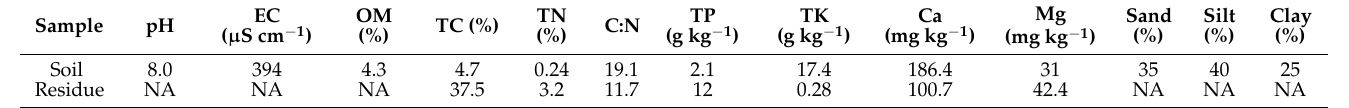
Table 1. Soil physico-chemical properties and chili residue